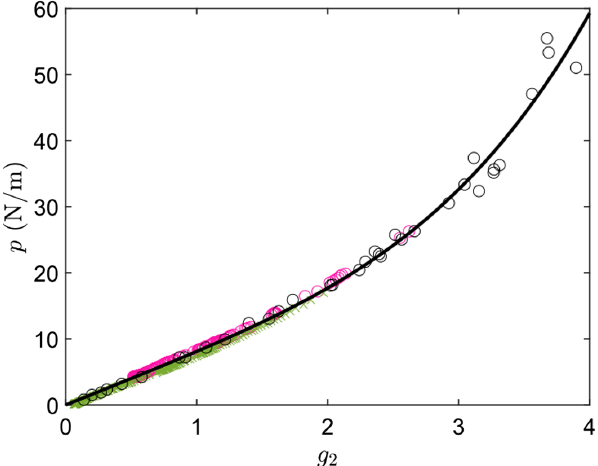
FIG. 11. The pressure p calculated from contact forces solved using the nonlinear fitting algorithm plotted as a function of g 2 . The black circles are original states, and the colored data points are states formed during cyclic shearing for two different experiments. The black curve plots Eq.